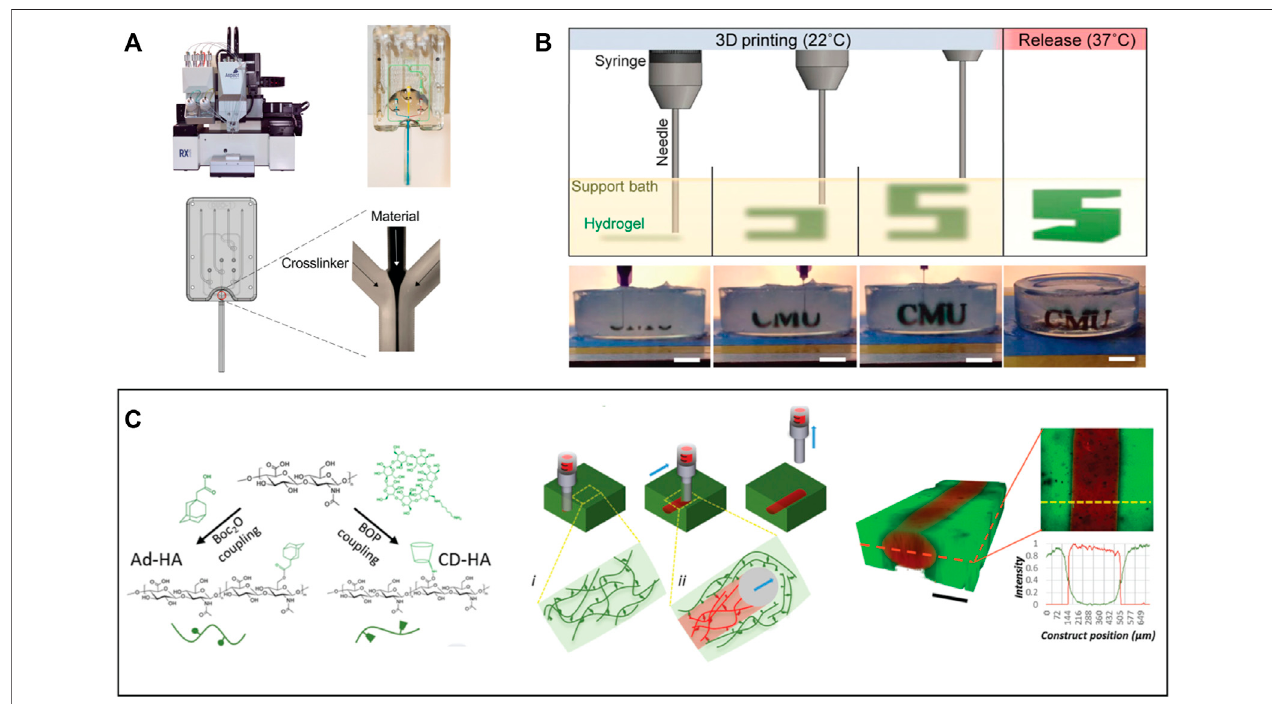
FIGURE 5 | Examples of emerging 3D printing approaches: (A) 3D bioprinting system with a micro fl uidic printhead that can load multiple biomaterials in different channels(Reproducedwithpermission fromDickman et al.,2020). (B) Schematic andimages ofFRESHprintedalginategelsembeddedingelatinslurrybath. Scalebar =1 cm(Reproducedwithpermissionfrom Hintonet al.,2015). (C) ExtrudedFRESHprintingofHAhydrogel intoself-healingsupport hydrogel bath.Scale bar=200 μ m (Reproduced with permission from Highley et al.,